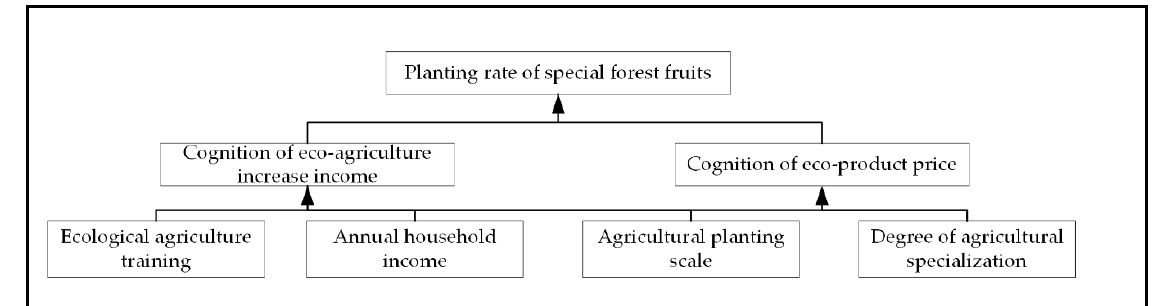
Figure 8. Explanatory structural model of planting rate of specialty orchard fruits.